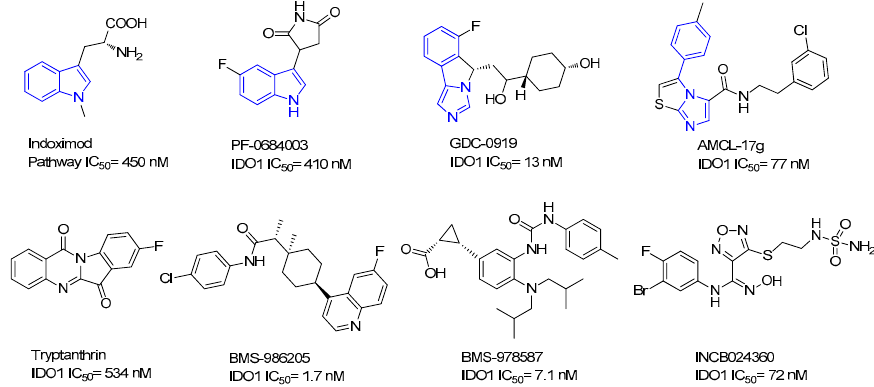
Figure 1. Reported IDO1 inhibitors. Indoximod and PF-0684003 have an indole scaffold and GDC- ff 0919 and AMCL-17g have a phenylimidazole scaffold. and AMCL-17g have a phenylimidazole sca